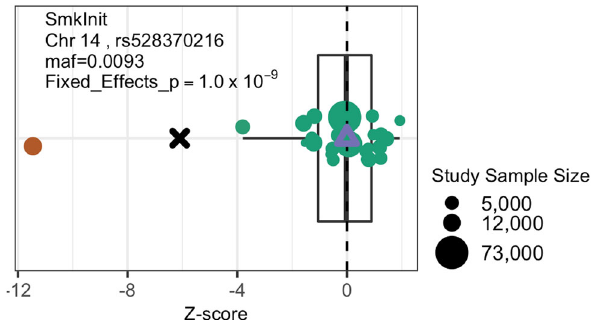
Fig. 1 Cohort level Z-scores for a genome-wide signi fi cant SNP that was identi fi ed as non-replicable for a Smoking Initiation (SmkInit) phenotype from GSCAN Consortium. Cross-mark indicates the meta-analysis z-score from a two-sided hypothesis test unadjusted for multiple comparisons. The size of the dot is proportional to the sample size of the cohort. Identi fi ed “ outlier ” summary statistic is marked as orange, which has a disproportionally large Z-score and drives the meta-analysis association results. The purple triangle indicates the MAMBA estimated Z-score, the posterior probability of replicability is 9 × 10 − 22 , very close to 0. Source data are provided as a Source Data fi